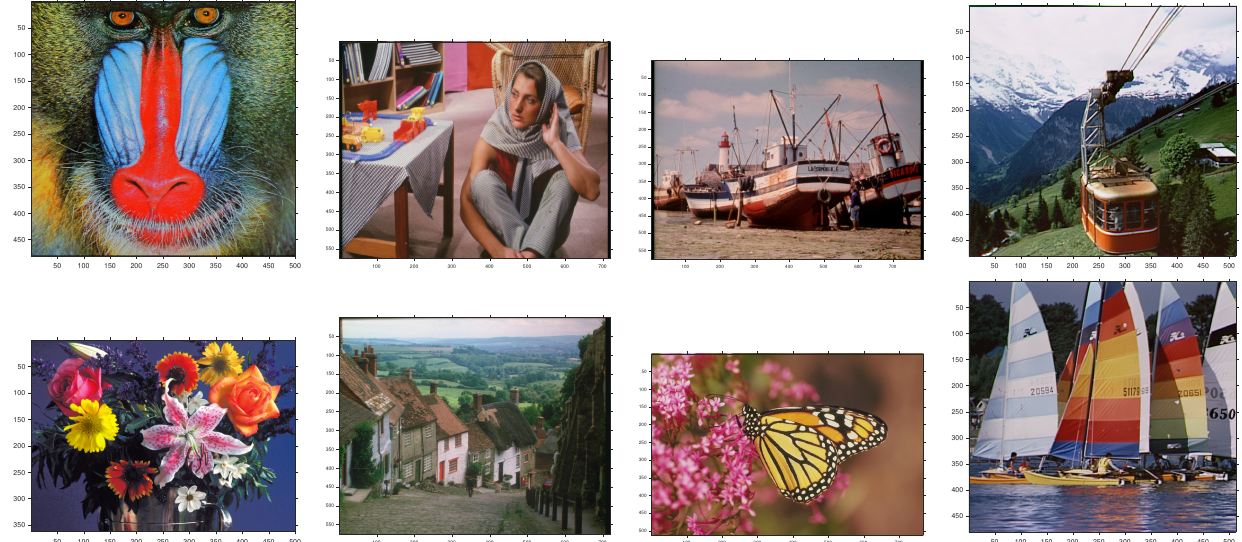
Figure 14. Natural images. ( Top ) From left to right: Baboon, Barbara, Boats, Cablecar; ( Bottom ) From left to right: Flowers, Goldhill, Monarch, and Yacht.